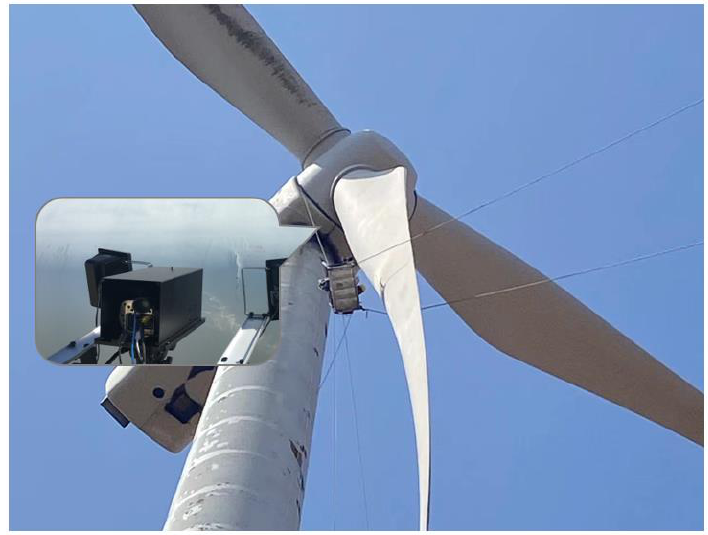
Figure 2. Infrared thermal image detection of in-service blade spar cap.